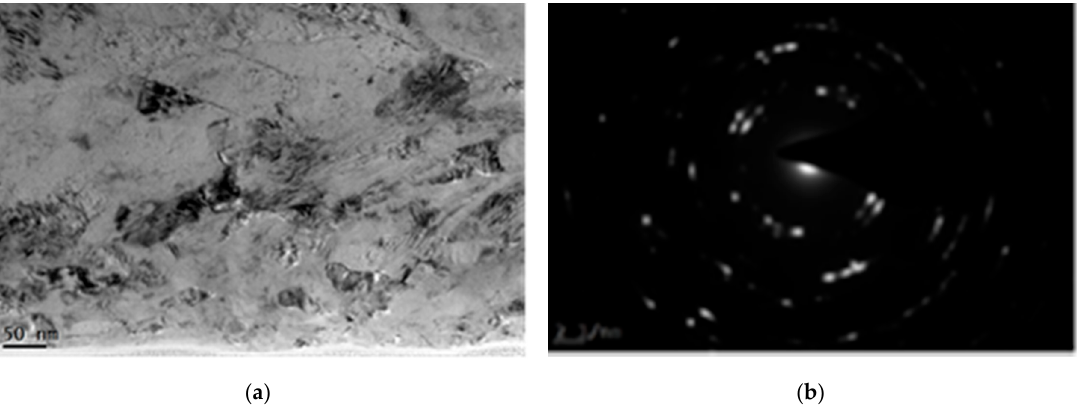
Figure 7. The locally enlarged cross-sectional TEM image of the laser treated GH3039 superalloy ( a ) and the corresponding selected area electron diffraction pattern ( b ).